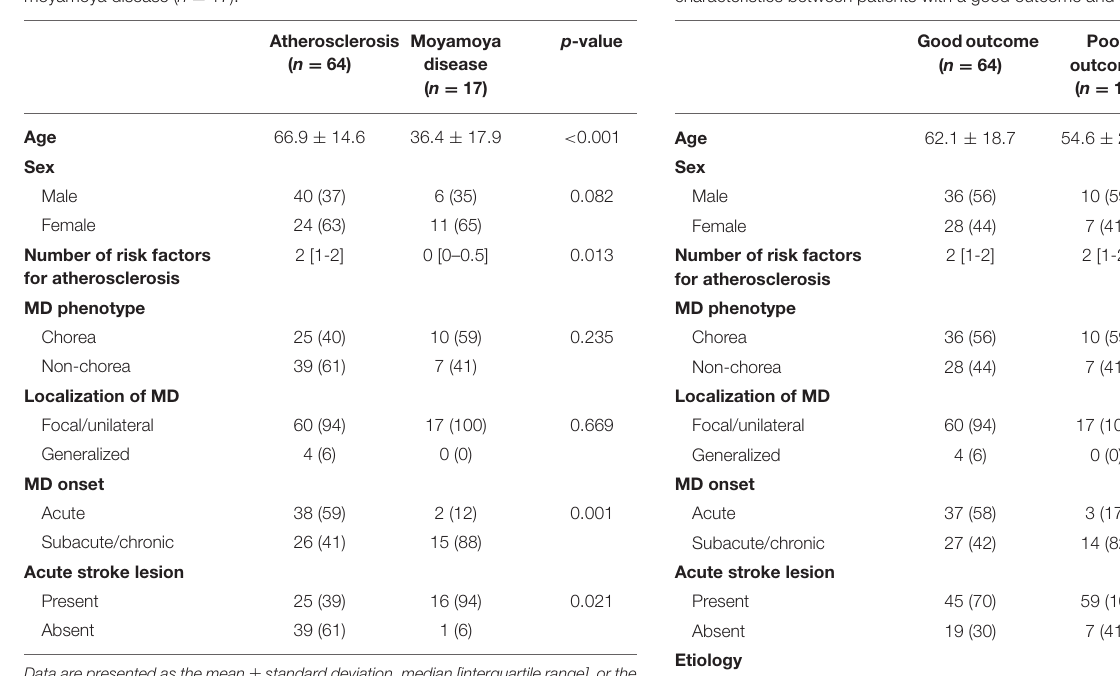
TABLE 3 | Comparison of demographics, MD characteristics, and CAS characteristics between patients with a good outcome and a poor